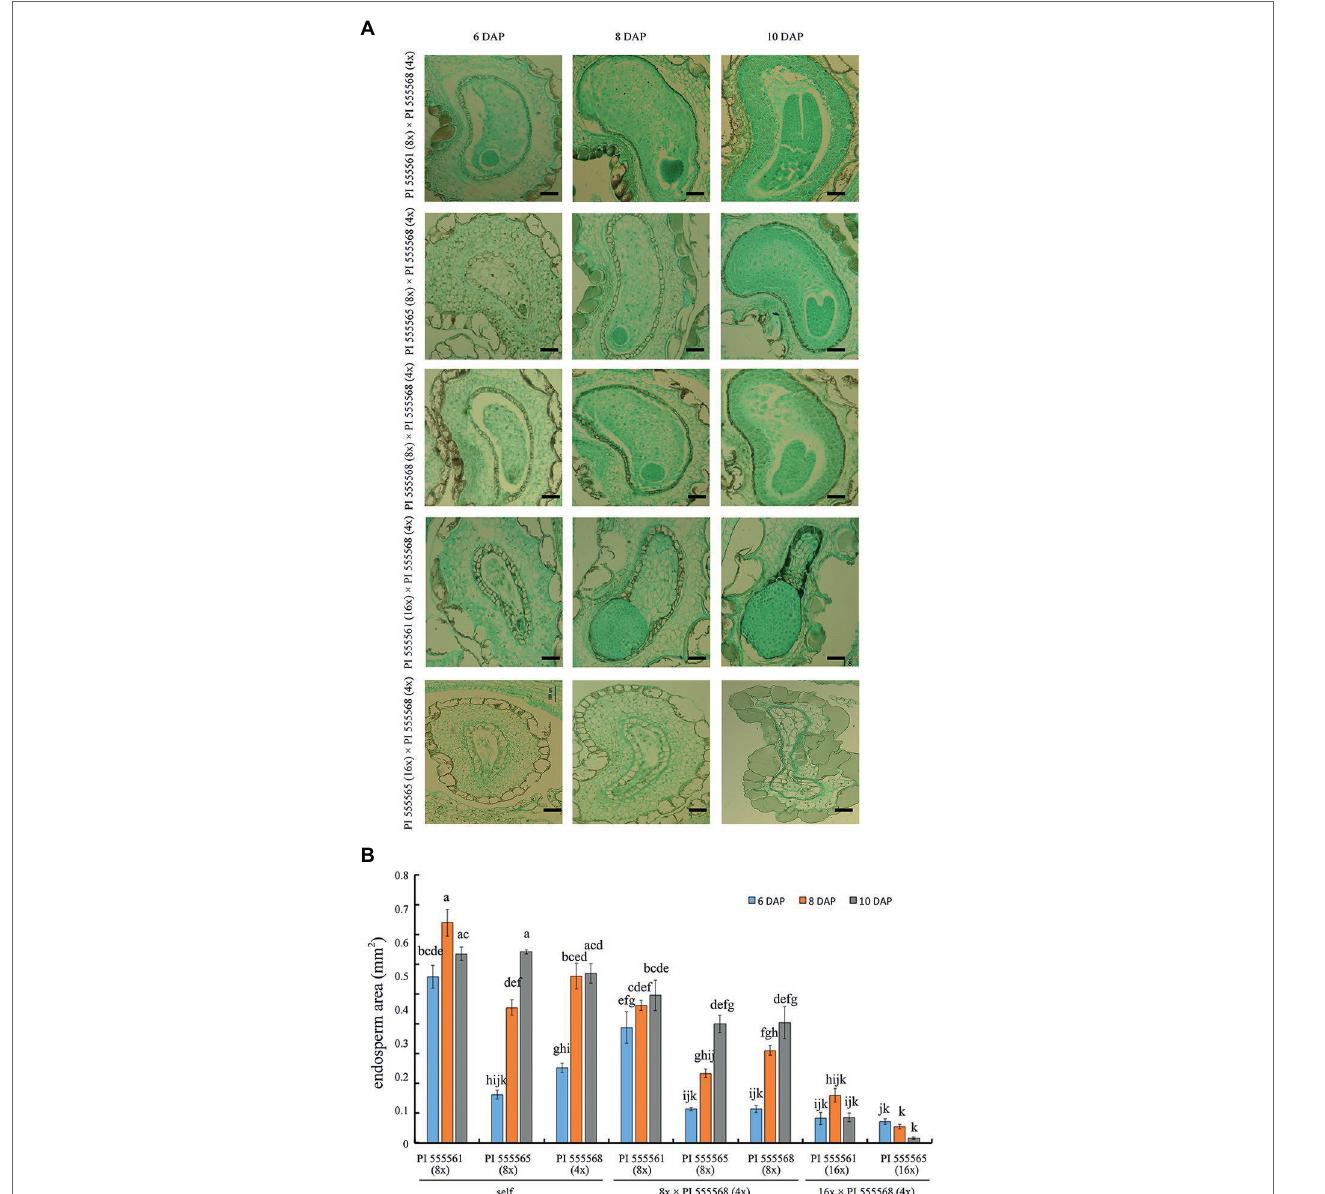
FIGURE 5 | Seed development in intraspecific-interploidy crosses of Nicotiana suaveolens . (A) Abnormal endosperm and embryo development. Normal endosperm and embryo development were observed in 8x × 4x crosses, while type I and type II hybrid seed lethality were observed in crosses between PI 555561 (16x) or PI 555565 (16x) and PI 555568 (4x), respectively. Scale bars = 200 μ m. (B) The surface area of the endosperm. Bars represent standard error ( n = 5 at 6 and 8 DAP, and n = 3 at 10 DAP). Different lowercase letters indicate significant differences at the 5% level as per Tukey’s